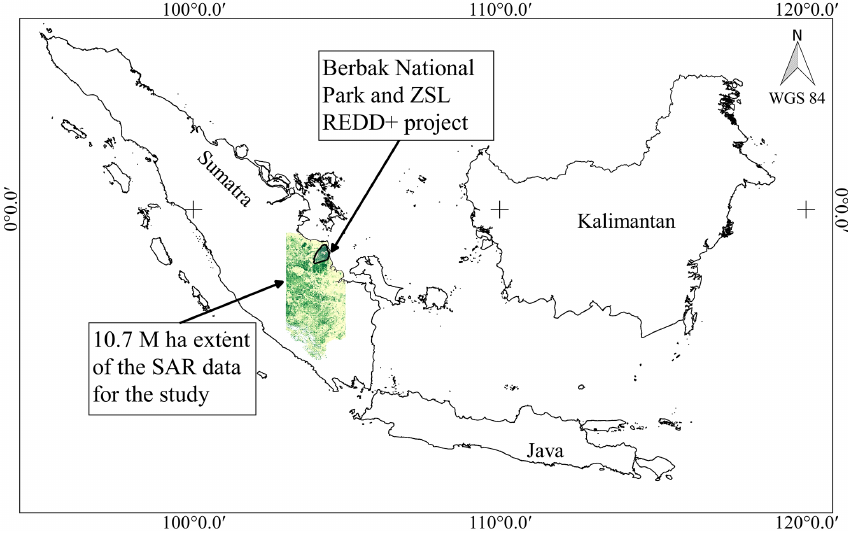
Figure 1. A map of the western islands of the Indonesian archipelago. The island oriented north-west to south-east is Sumatra. The section highlighted is our study area of 10.7Mha. The underlying data for that section constitute our estimate of AGB for 2007. Dark-green areas are those with high AGB, and lighter coloured areas have very low AGB. In the northernmost tip of the image is the dark green of Berbak National Park, reflecting its relatively intact status. It was from this site that we gathered our field data via ZSL, which operates a pilot REDD + project there. The south of the study area terminates at the Bukit Barisan mountain